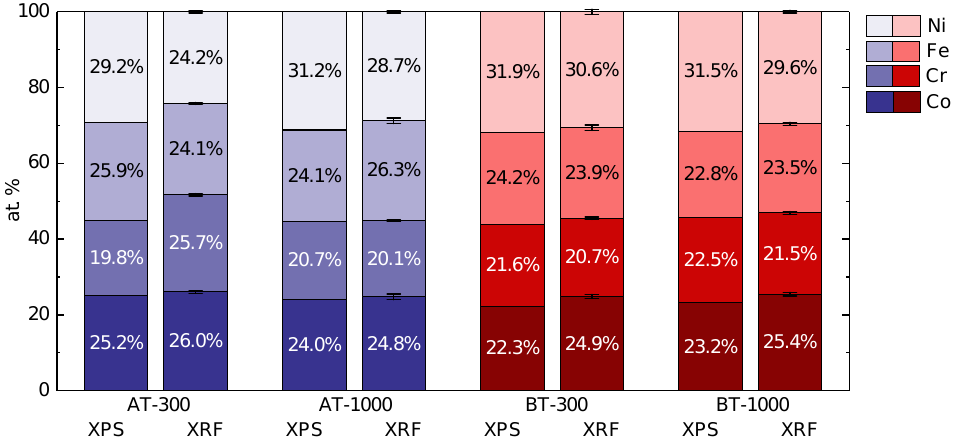
Figure 5. Composition of the deposited thin films as determined by X-ray photoelectron spectroscopy (XPS) and X-ray fluorescence (XRF). The error bars for XRF data represent the standard deviation obtained from several measurements across the